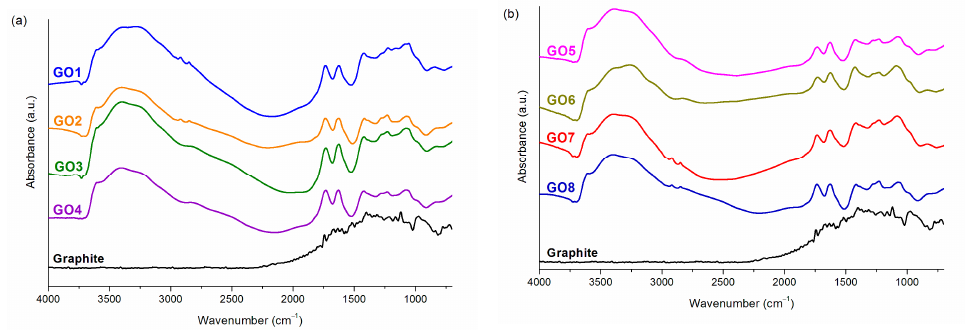
Figure 1. ( a ) FTIR spectra of graphite and GO1–4; ( b ) FTIR spectra of graphite and GO5–8.